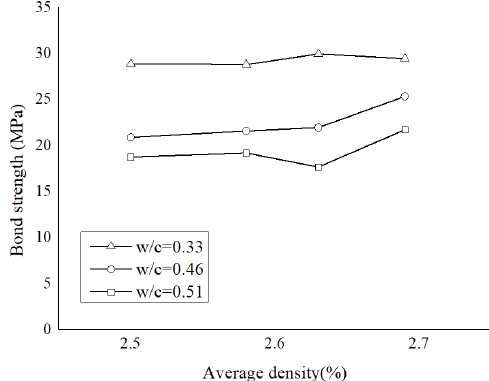
Figure 10: Relationship between bond strength and density